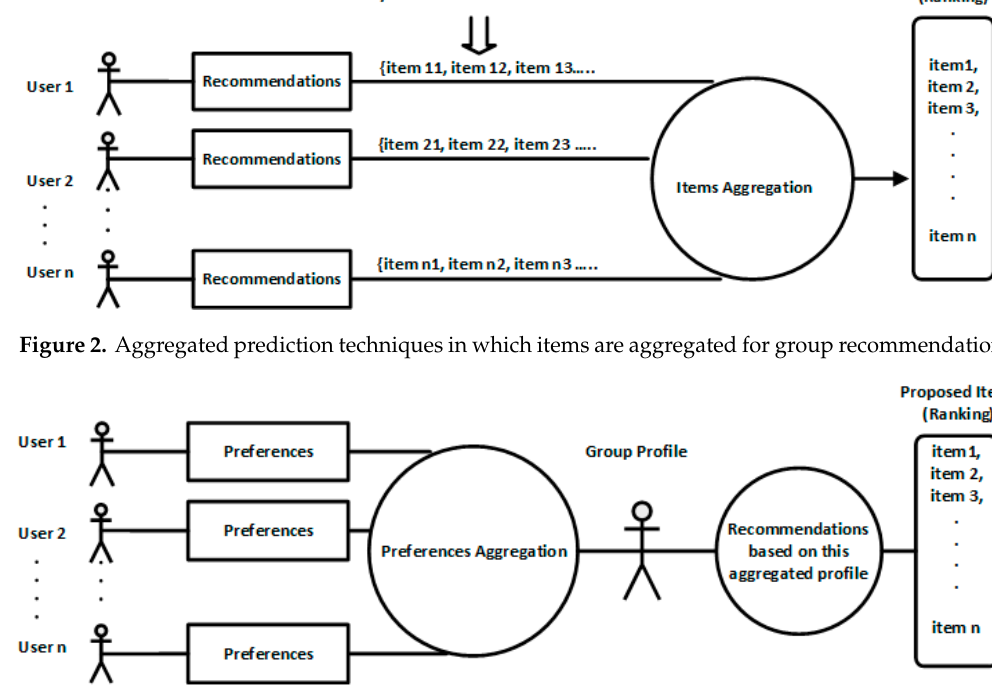
Figure 3. Aggregated model for preferences merging in which preferences of individuals are aggregated for group recommendations.